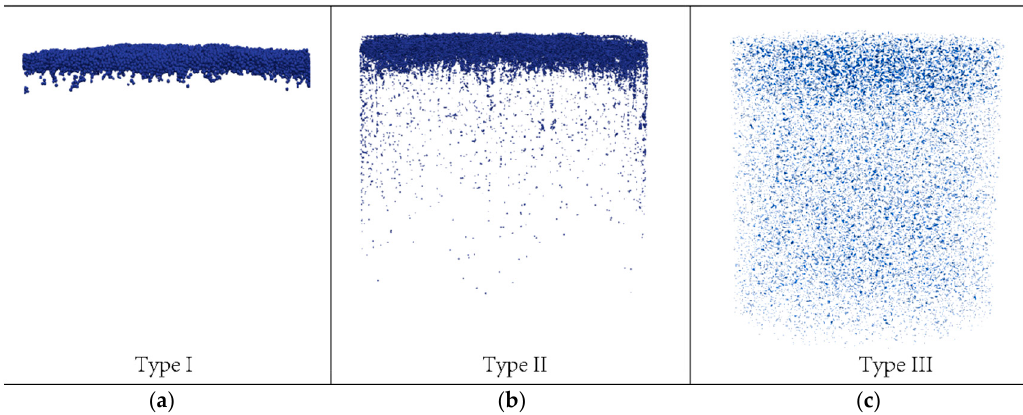
Figure 7. Extracted slurry particles inside the sand column: ( a ) Type I; ( b ) Type II; ( c ) Type III.